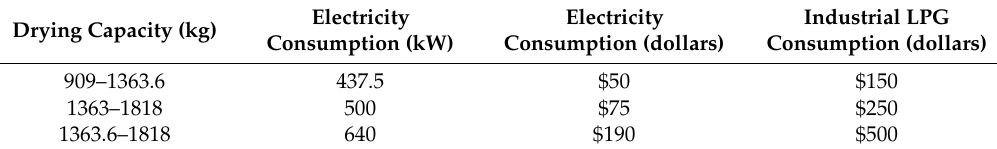
Table 1. Estimate of electricity and industrial LPG